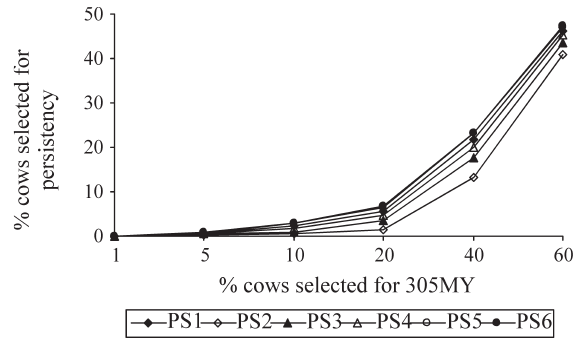
Figure 5 - Percentage of cows selected for persistency of lactation (PS